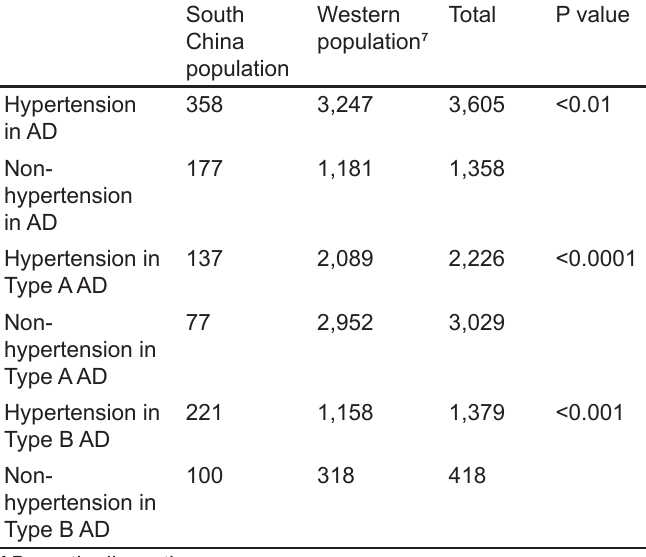
Table 2. Differences in total hypertension rate in aortic dissection